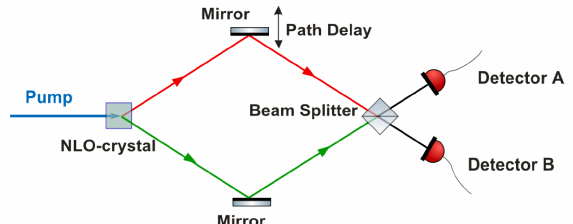
Figure 6. Hong–Ou–Mandel setup for observation of a dip in the signal-idler photon coincidence rate at Detectors A and B. The signal and idler fields, which are assumed here to have the same frequency and polarization, are reflected by the upper and lower mirrors, respectively and can either be reflected or transmitted by the beam splitter